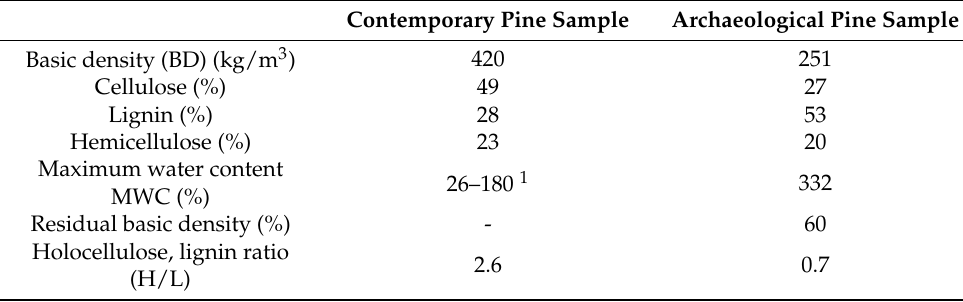
Table 1. Physical and chemical properties of the object.